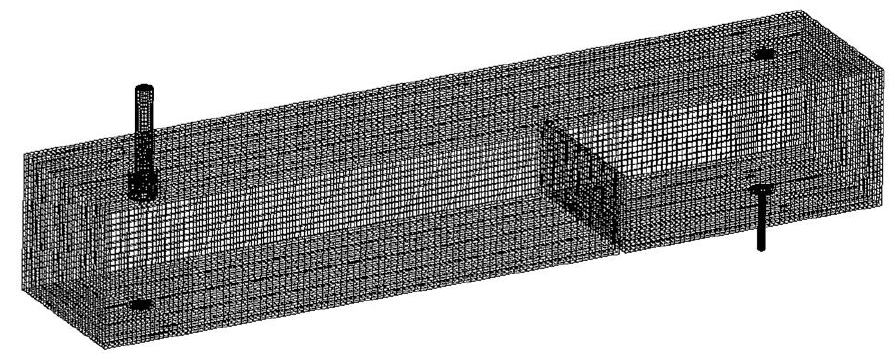
Figure 2. The structured mesh of single strand tundish.